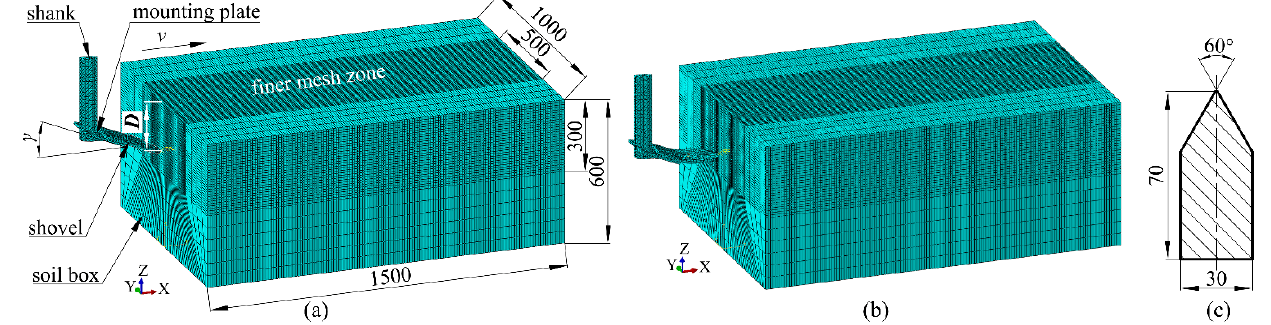
Figure 3. FE models for the interactions between soil and a single shovel (dimensions in mm). ( a ) Finite element mesh of soil box being cut with single DZ, ( b ) finite element mesh of soil box being cut with single YS and ( c ) the cross section of shank. γ is the mounting angle (the angle between the mounting plate and cutting direction), D is the digging depth and v is the cutting speed.